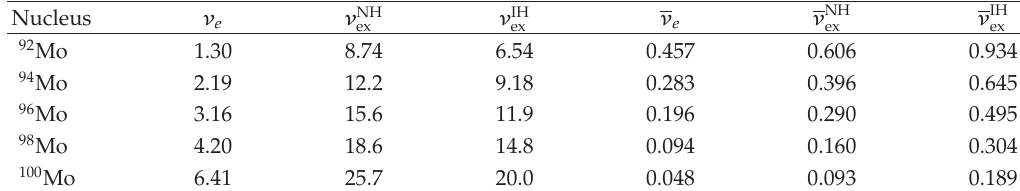
Table 4: Average neutrino energies and values of the parameter α for the two sets of neutrino parameters adopted in the present calculations. In the table, x denotes the nonelectron flavors, that is, x (cid:7) μ,τ . Parameter set